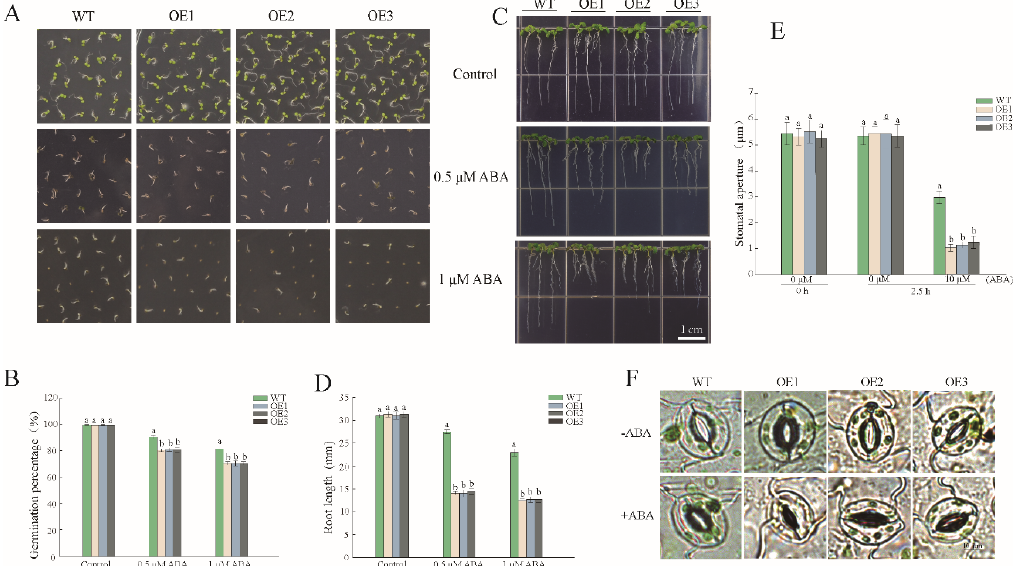
Figure 7. Overexpression of PwNAC38 improved the sensitivity of transgenic Arabidopsis to ABA. ( A , B ) Statistics of germination rate under ABA treatment. ( C , D ) Statistics of seedling root length under ABA treatment. ( E , F ) Representative epidermal stoma taken by biomicroscope (DM2500, Leica) treated with or without ABA. The significantly different mean values at p ≤ 0.05 were labeled by different